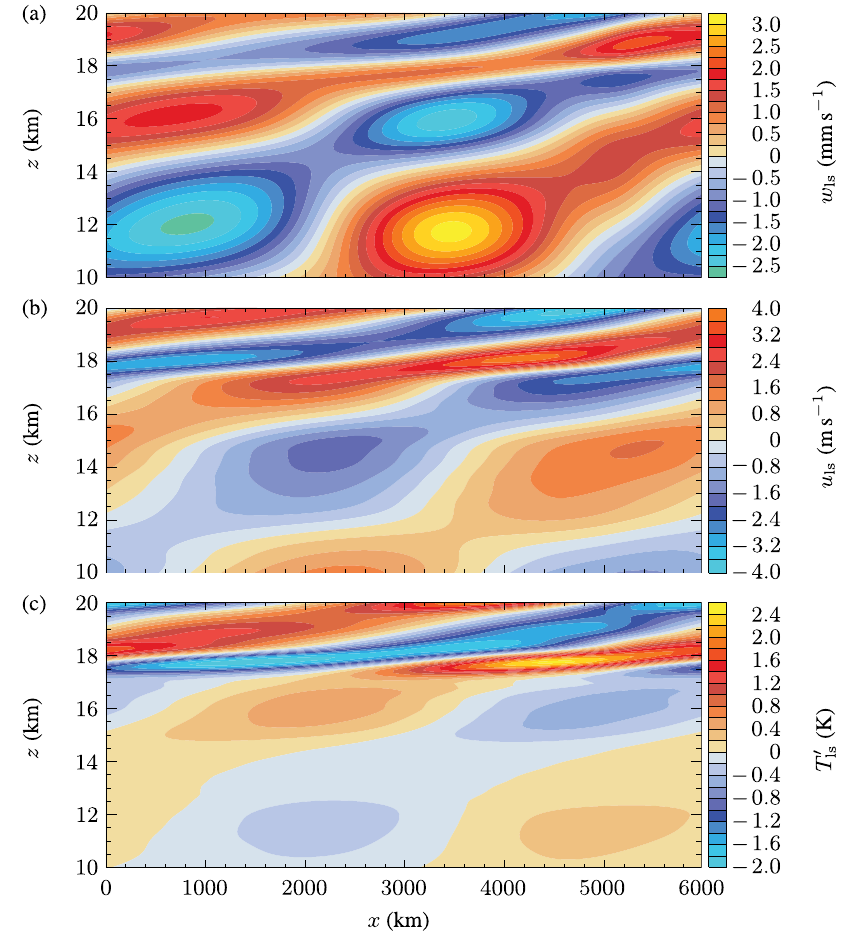
Fig. 3. Wave vertical velocity (a) , horizontal velocity (b) , and temperature perturbations (c) at 92d.